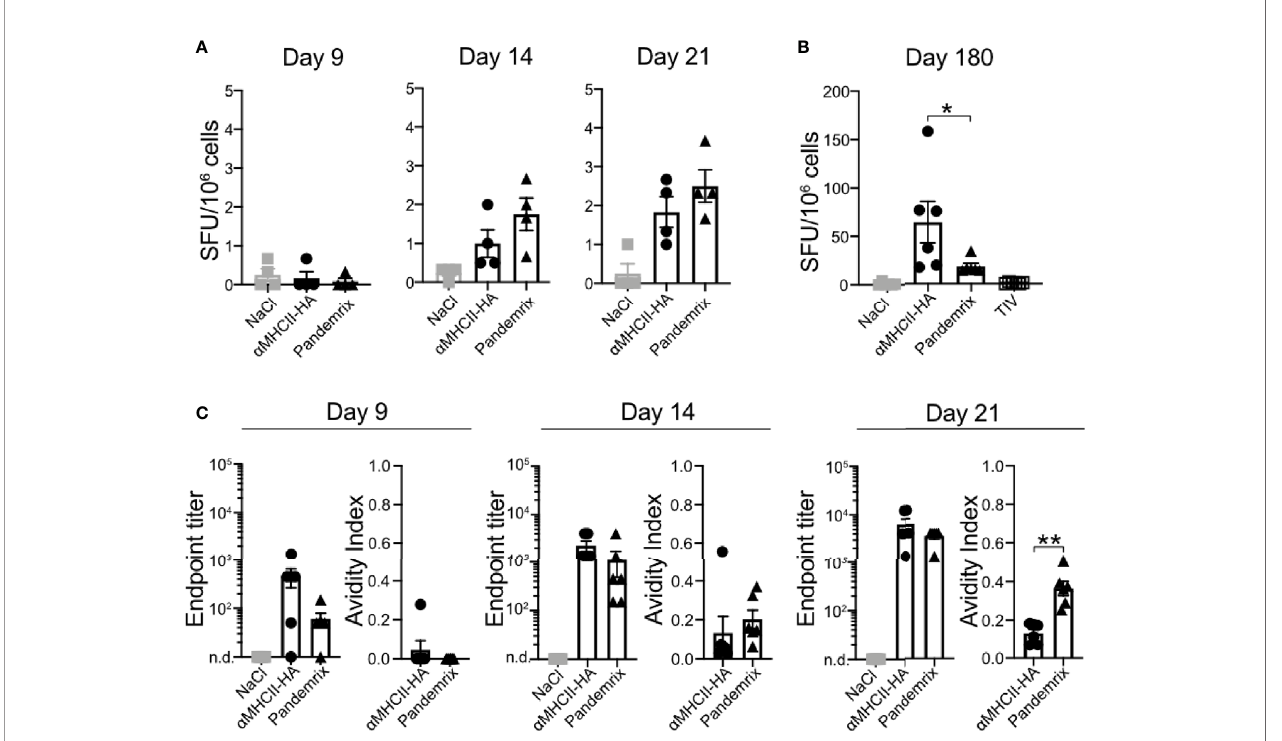
FIGURE 3 | Plasma cells in bone marrow and antibody avidity after vaccination. Mice (n=6/group) were vaccinated i.m. with the indicated vaccines. (A, B) Bone marrow (tibia) was harvested, and anti-HA secreting cells examined by ELISpot at (A) days 9, 14, and 21 after vaccination, or (B) day 180 post vaccination. (C) Antibody titers and avidity index of serum antibodies against HA as measured in ELISA from the indicated time points post vaccination. Data shown are mean ± SEM, *P < 0.05, **P < 0.01